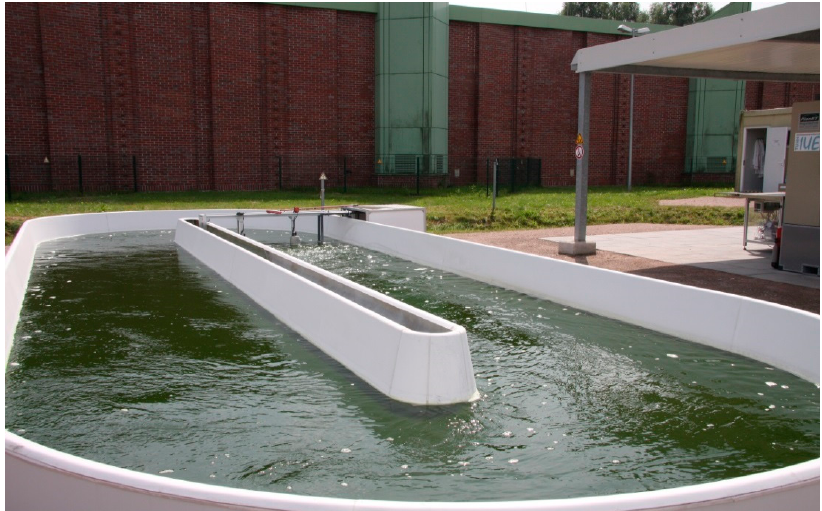
Int. J. Environ. Res. Public Health 2020 , 17 , x FOR PEER REVIEW Figure 5. Open pond cultivation system. Figure 5. Open pond cultivation system.